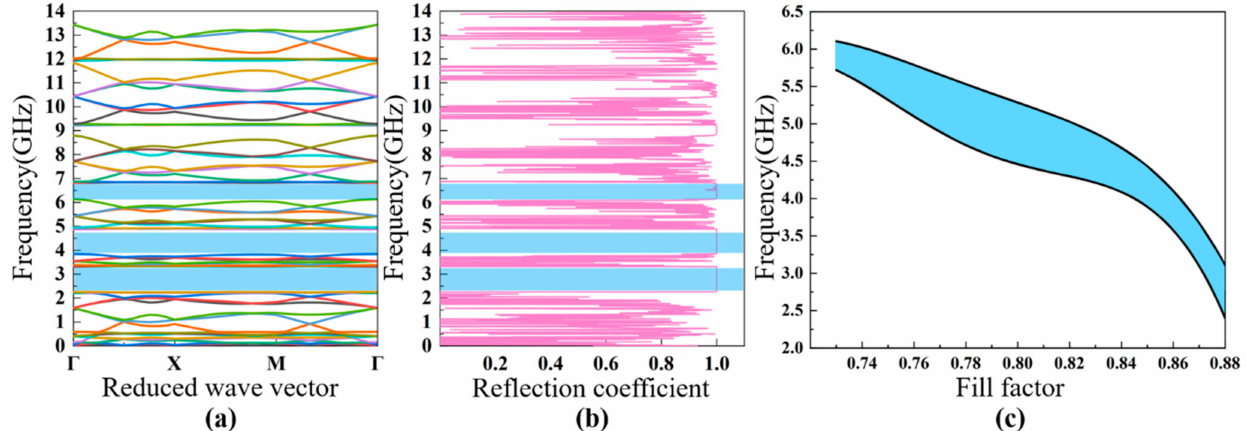
Figure 6. The calculated band diagram ( a ) and reflection coefficient ( b ) of the honeycomb lattice PhC with the lattice = 0.44 µ m. The dependence of the width of the bandgap on the fill factor ( c ). parameters of a = 0.9 µ m, d 2